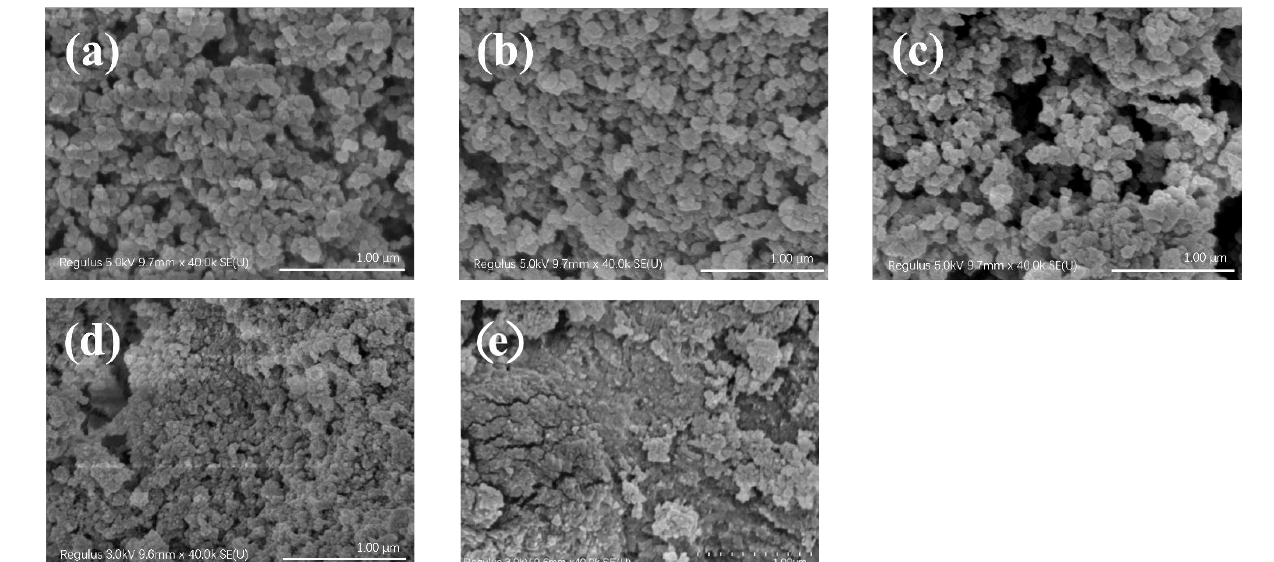
Figure 4. SEM images of CS-PA-CD nanoparticles with different ratios of PA-CD to CS: 2:1( a ), 1.5:1( b ), 1:1( c ), 1:1.5( d ), 1:2( e